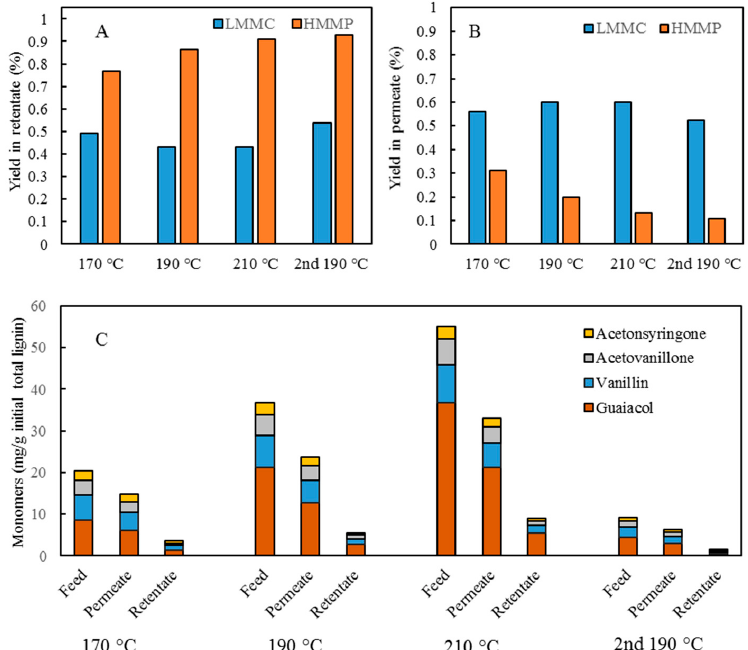
Figure 8. Comparison of LMMC, high molecular mass polymers (HMMP), and aromatic monomers before and after membrane filtration. ( A ) LMMC and HMMP contents in retentate after filtration. ( B ) LMMC and HMMP contents in permeate after filtration. ( C ) Monomer contents in Feed (D170, D190, D210, and 2D190) and both permeate and retentate after membrane